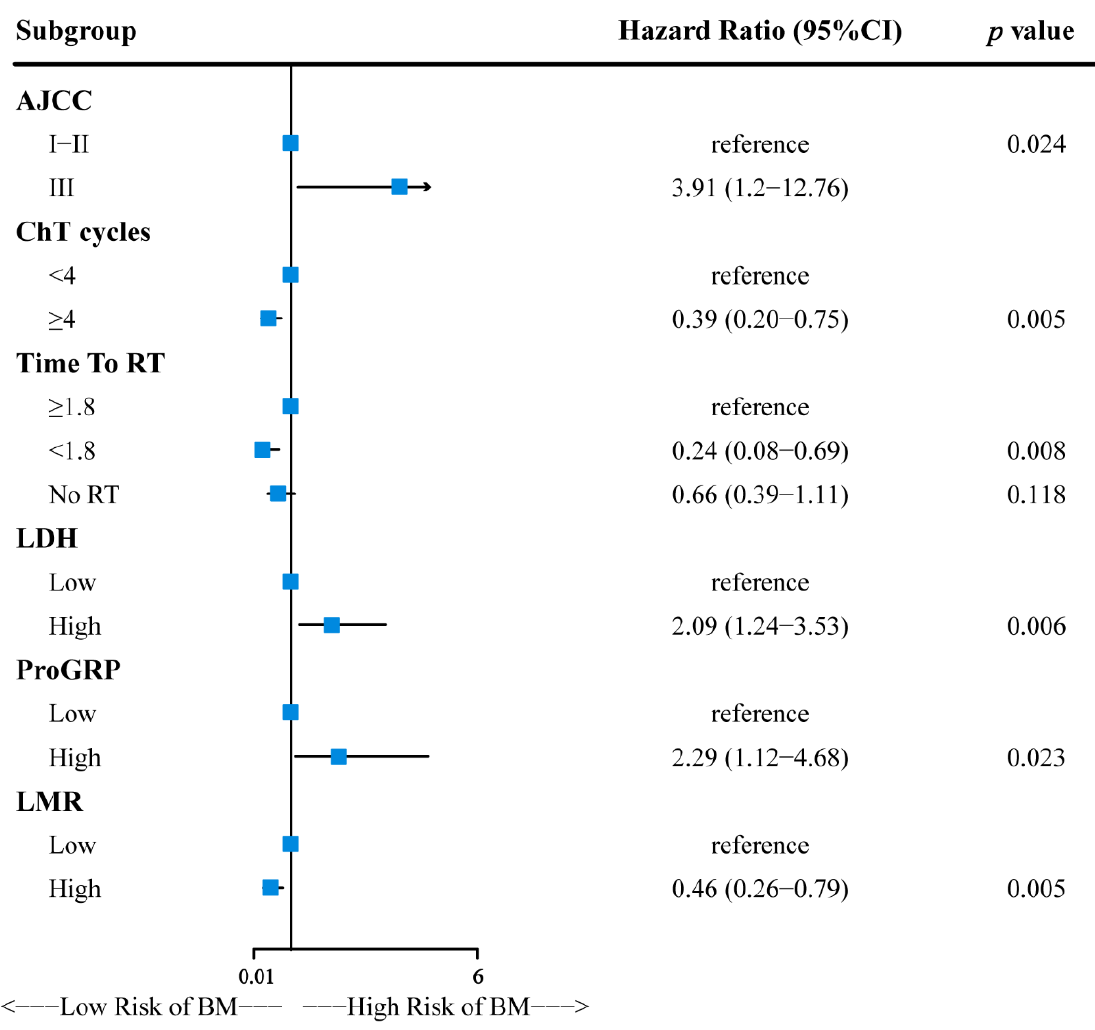
Figure 2. Forest plot for multivariate Cox regression analysis and 95% confidence intervals.